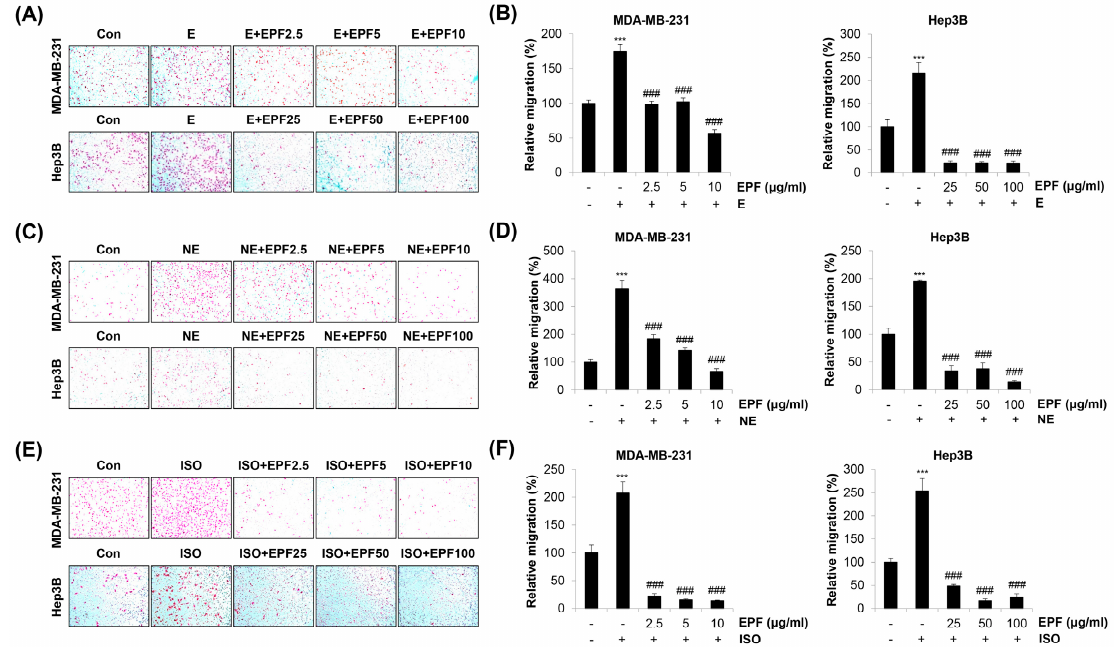
Figure 5. EPF suppresses E/NE/ISO-induced migration of cancer cells. MDA-MB-231 human breast cancer cells and Hep3B human hepatocellular carcinoma cells suspended in serum-free media were seeded into inserts of 24-well Transwell plates and treated with either E (10 µ M, A , B ), NE (1 µ M, C , D ), or ISO (10 µ M, E , F ) for 24 h in the presence of EPF at diverse concentrations (2.5–10 µ g/mL for MDA-MB-231; 25–100 µ g/mL for Hep3B). Medium containing 10% serum was added to the bottom chambers. After 24 h of incubation, migrated cells were stained and photographed ( × 100 magnification). Representative images from triplicate analyses are shown ( A , C , E ). Relative migration compared to that of untreated control cells was evaluated by counting stained cells ( B , D , F ). The data are expressed as the mean ± SD of three independent experiments. Significance was determined by the Student’s t -test (*** p < 0.001 vs. untreated controls; ### p < 0.001 vs. E/NE/ISO-treated cells). E, epinephrine; NE, norepinephrine; ISO, isoprenaline; EPF, ethanol ex- tract of Perilla frutescens leaves.